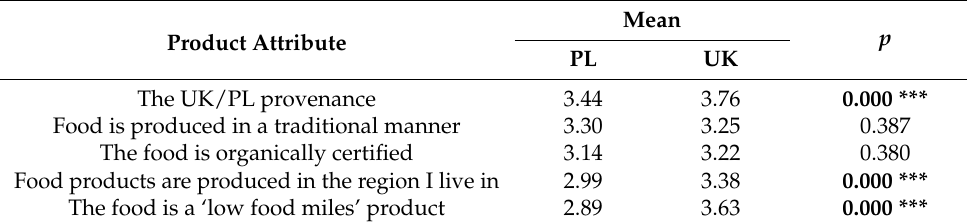
Table 4. The differences in significance of selected attributes of purchased food products between respondents from PL and the